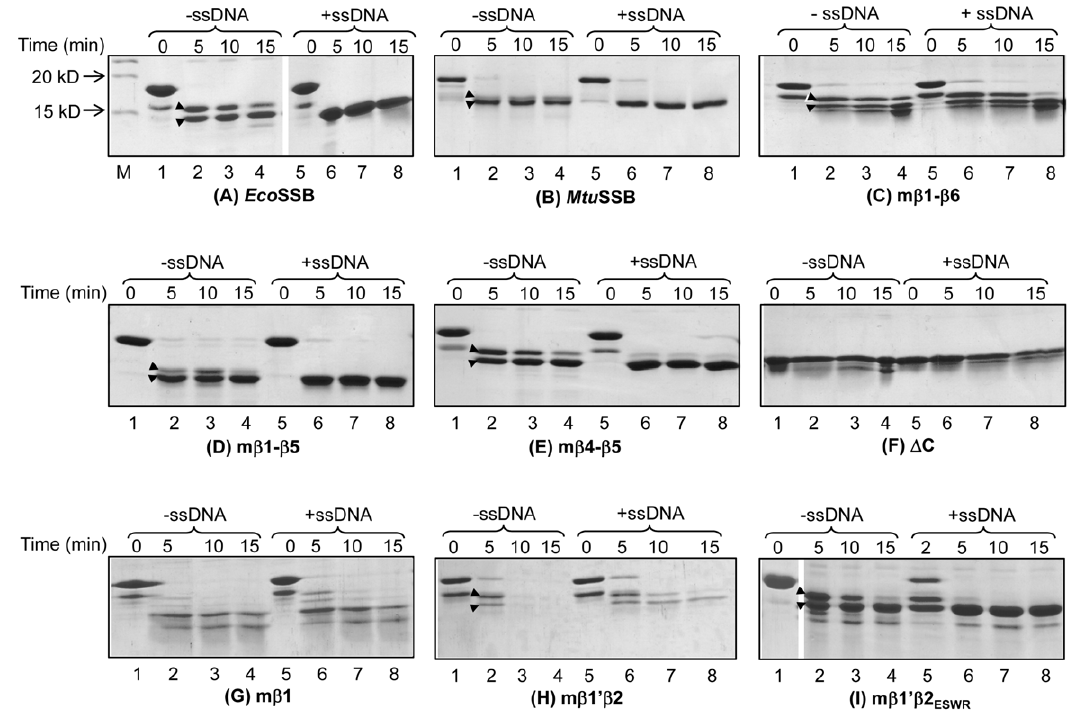
Figure 5. Digestion of SSBs with chymotrypsin. Approximately 2 m g of SSBs (as shown), in the absence or presence of the sheared and denatured genomic DNA were incubated with chymotrypsin for the indicated times and analyzed on SDS-PAGE (17.5%). M represents molecular size markers.